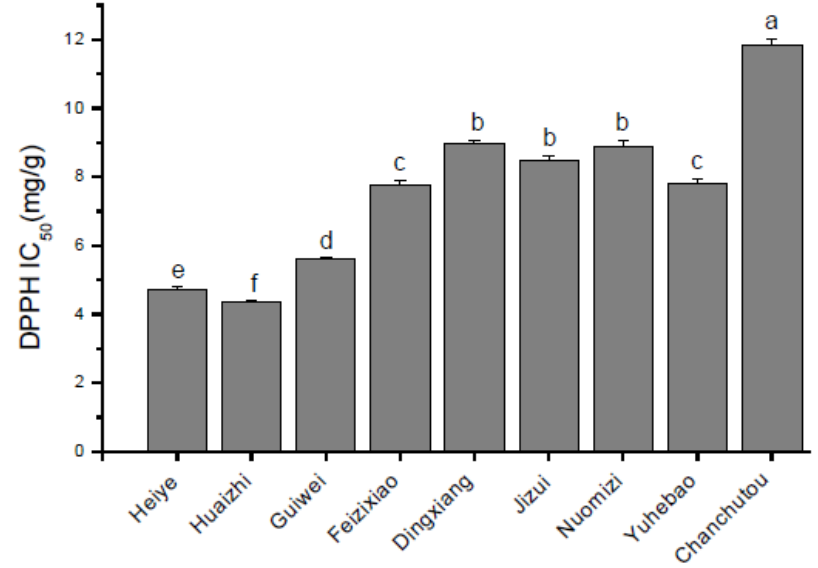
Figure 4. DPPH scavenging activities of phenolic extracts from the pericarp of nine litchi varieties (mean ± standard deviation, n = 6). Bars with no letters in common are significantly different ( p <